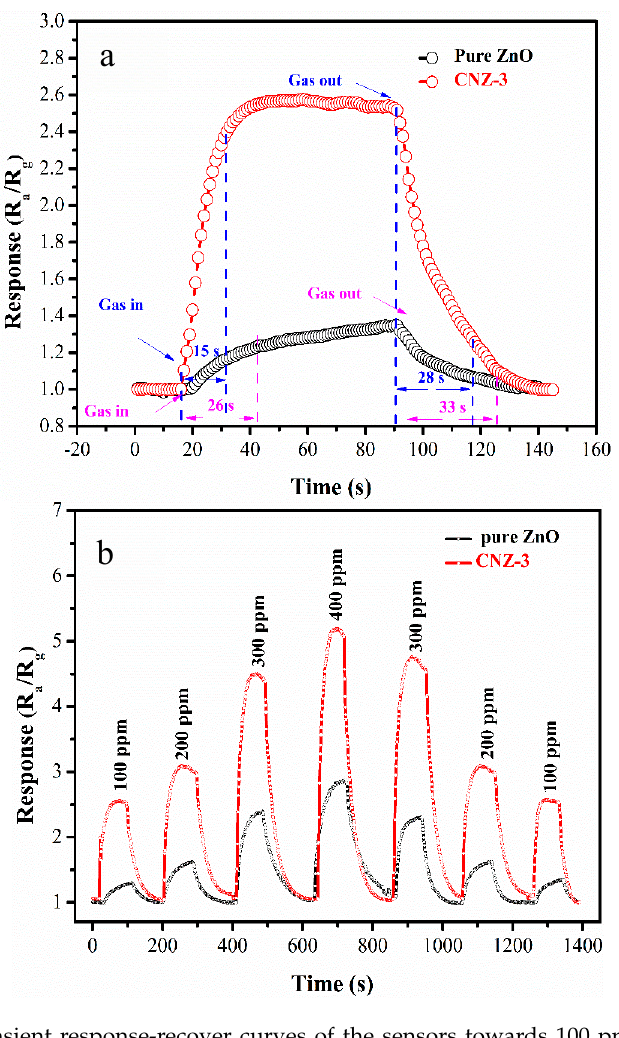
Figure 10. ( a ) Transient response-recover curves of the sensors towards 100 ppm CH 4 at 320 °C; ( b ) dynamic response of the sensors to different concentrations of CH 4 at 320 °C.